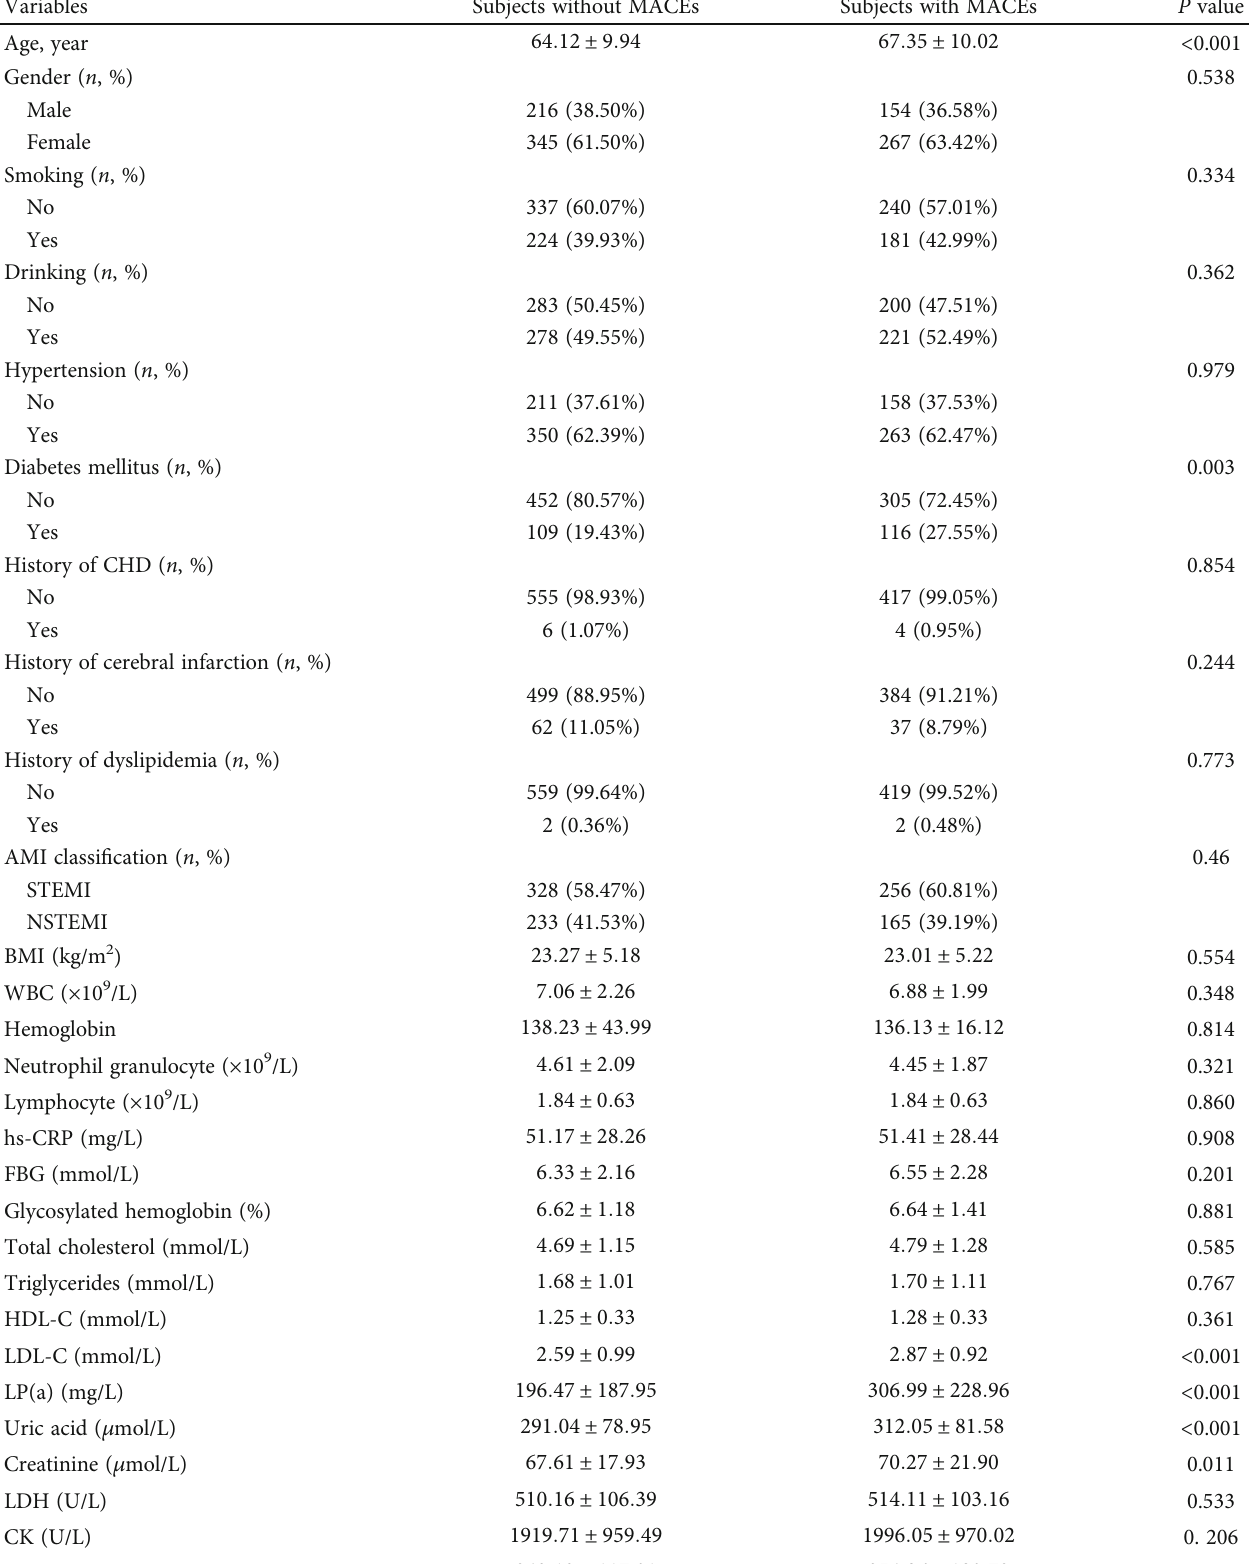
Table 1: Characteristics of the